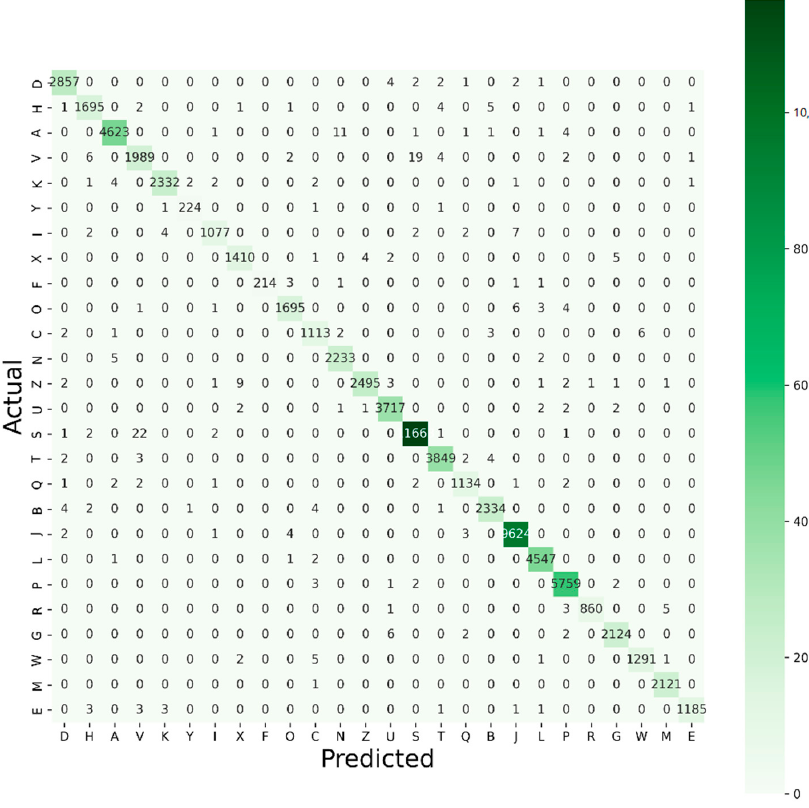
Figure 12. Confusion matrix of model K5 for A–Z recognition.